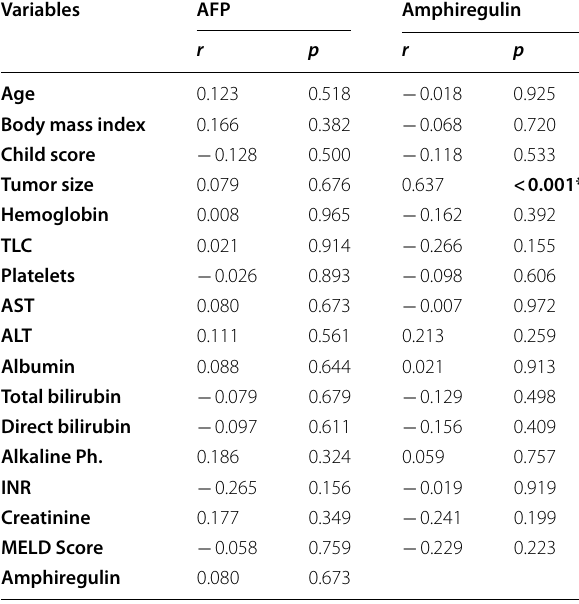
Table 2 Comparison between the two studied groups